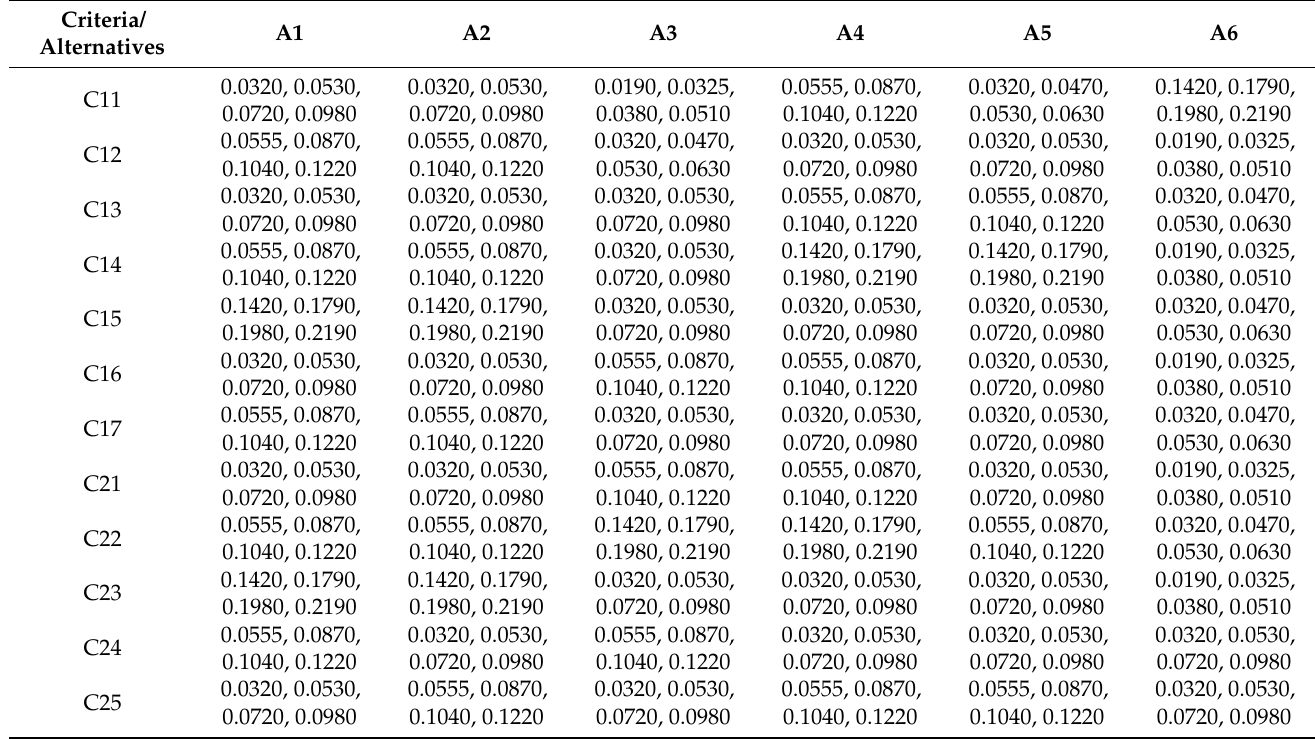
Table 8. The Weighted Normalized Fuzzy-Decision Matrix.